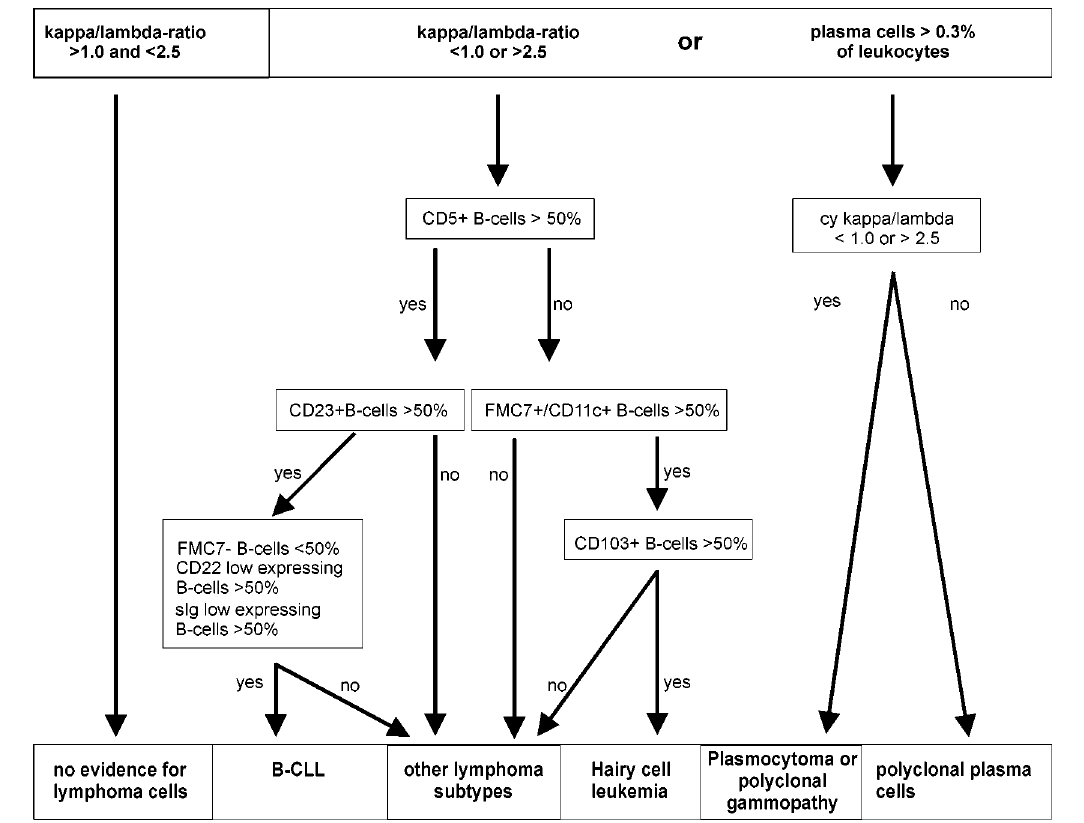
Fig. 4. Diagnostic scheme for the evaluation of immunophenotyping results following data analysis by the knowledge guided cluster analysis.